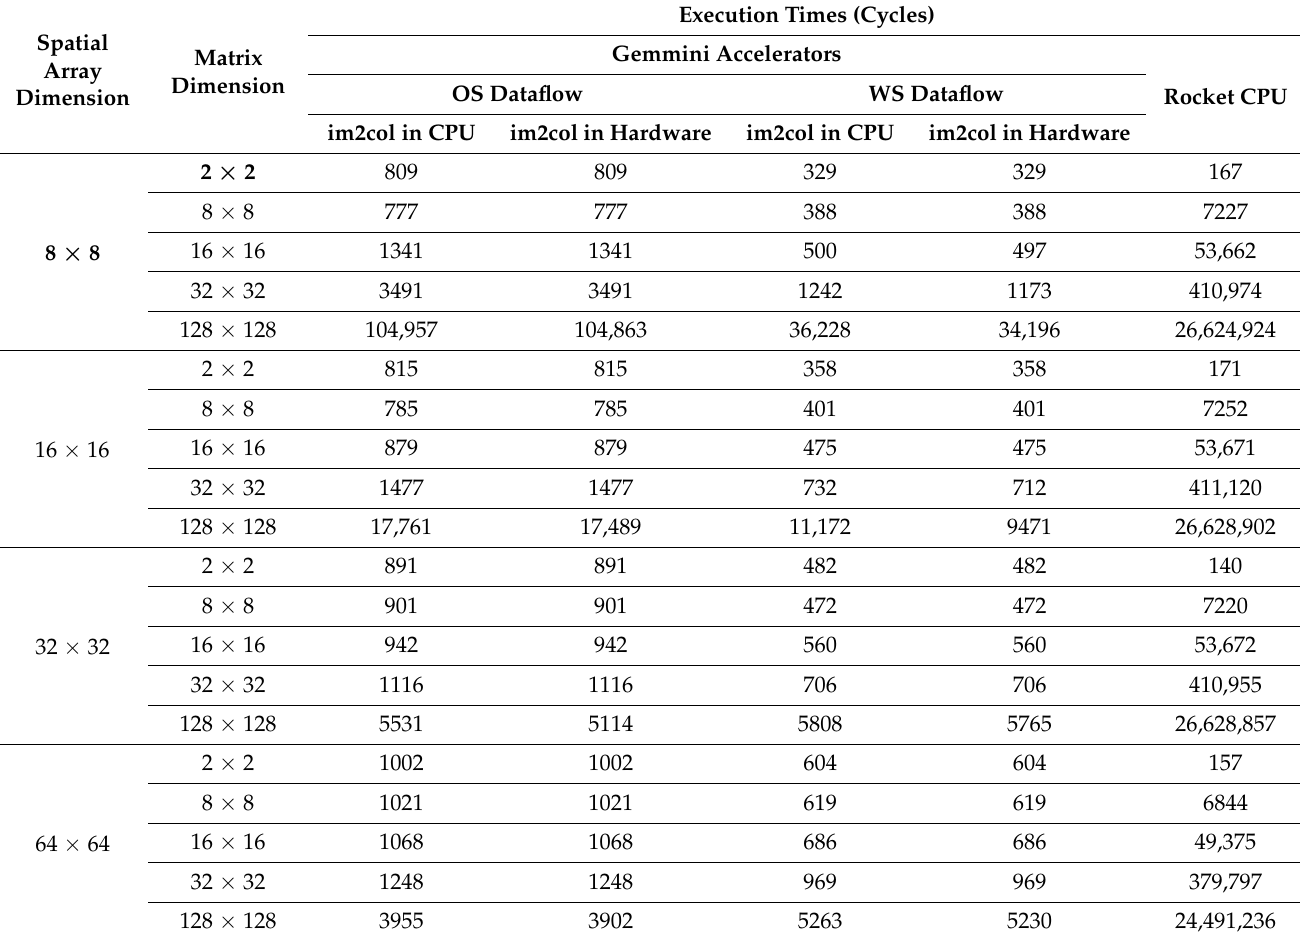
Table 1. GEMM workload performance on Gemmini and the Rocket CPU